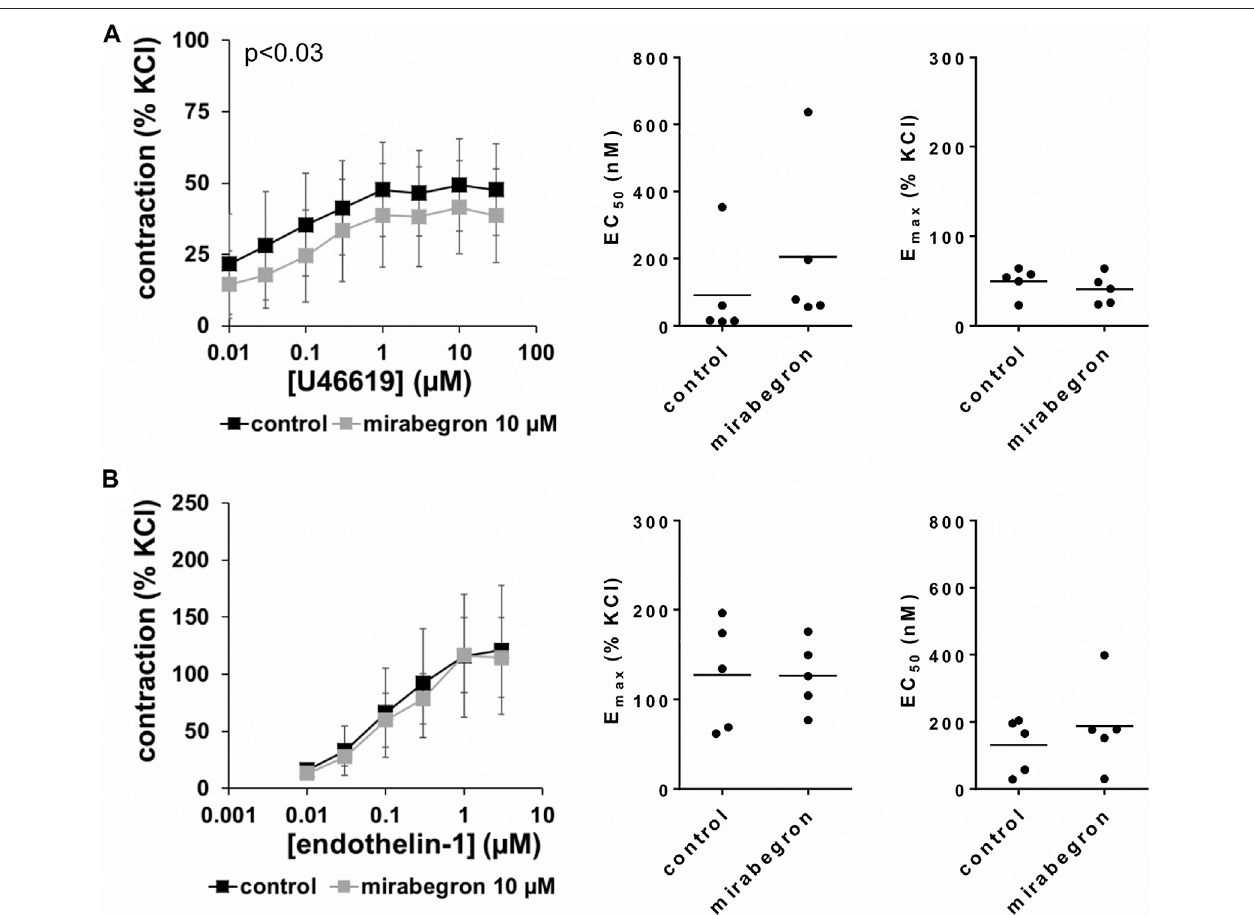
FIGURE 5 | Effects of 10 µM mirabegron on non-adrenergic contractions of human prostate tissues. Contractions of prostate tissues from the periurethral zone were induced by cumulative concentrations of the thromboxane A 2 analog U46619 (A) or endothelin-1 (B) in an organ bath, 30 min after addition of mirabegron or an equivalent amount of DMSO (controls), which was used as solvent for mirabegron. Shown are data from n (cid:1) 5 patients in each diagram, which are means ± SD in frequency response curves ( p value for whole groups in insert from 1-way ANOVA), and E max and EC 50 values for single experiments (calculated by curve fi tting) in scatter plots.